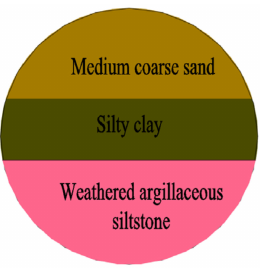
Figure 6. Typical geological section of the 1st to the 15th